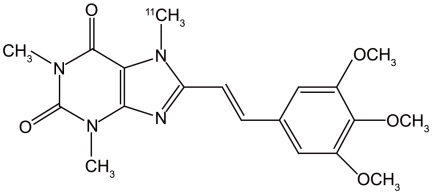
Structure of [11C]TMSX.